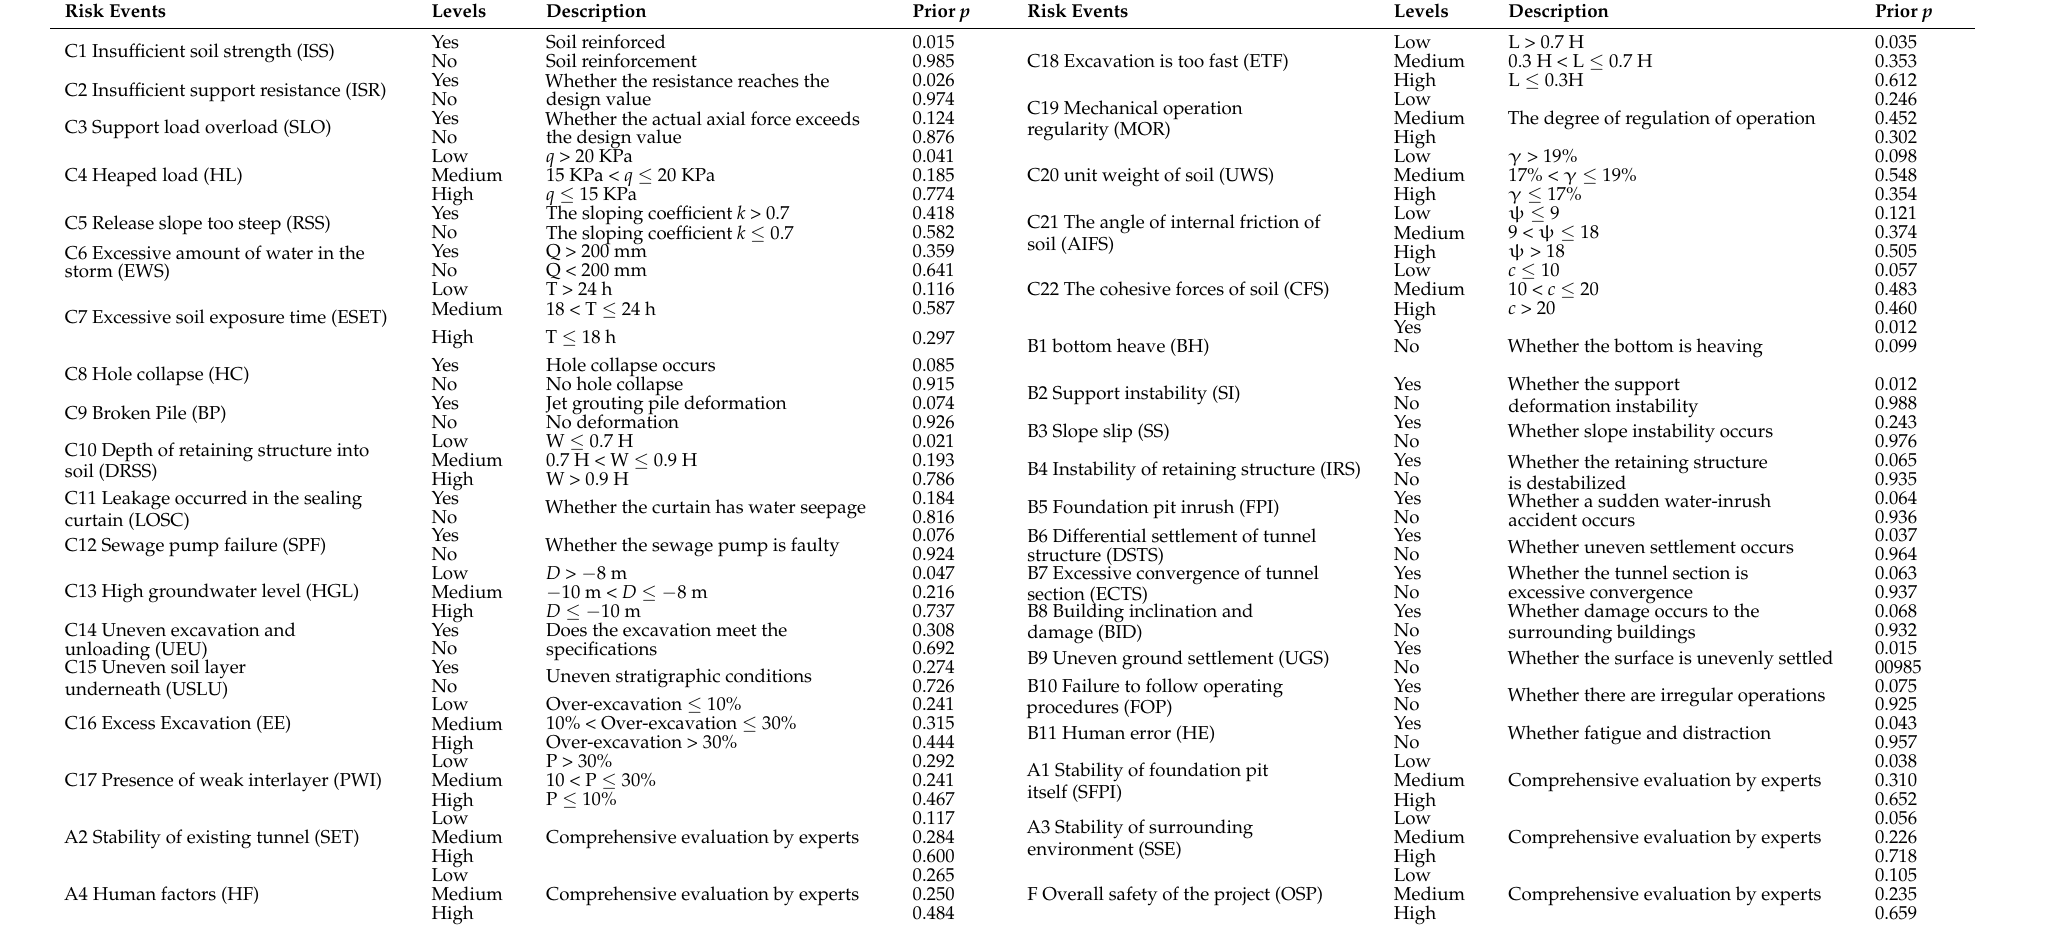
Table 2. Discrete state description and a priori probability of influence factors of DFPs in adjacent existing underpass